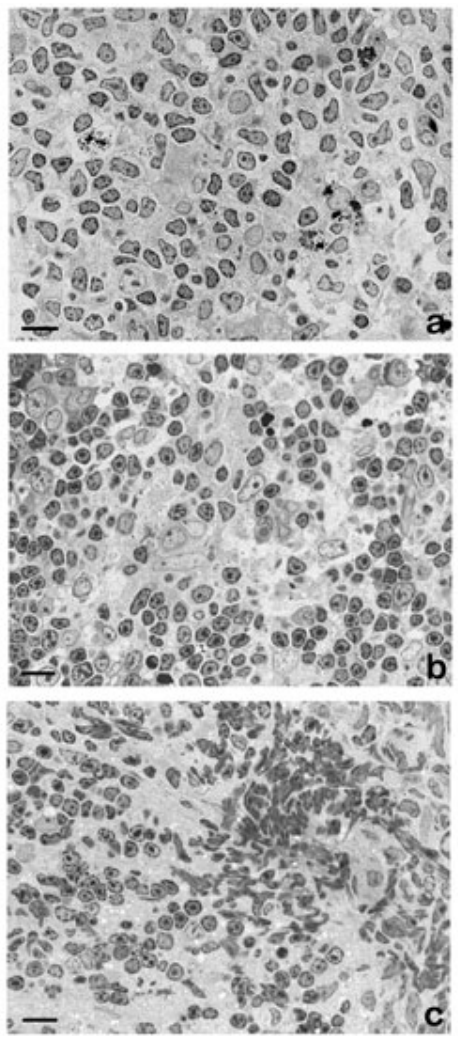
FIGURE 3 . Light microscopy of thymus from 10-month-old rats exposed for 8 months to CL (a) and to 50-Hz sinusoidal EMF at two levels of field intensity (b, 1 kV/m, 5 µ T and c, 5 kV/m, 100 µ T). Cell death, in particular necrosis and clustered cell death, was more pronounced after EMF exposure (b,c). Bar: 10 µ m.